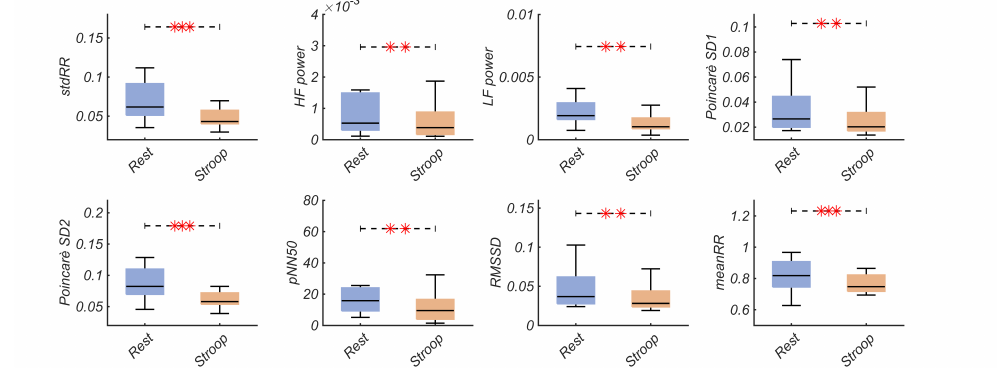
Figure 5. Results from the Wilcoxon sign-rank test considering the HRV-derived features. Statistically significant comparisons resulting in p < 0.01 are highlighted with ** and those resulting in p < 0.001 are highlighted with ***.